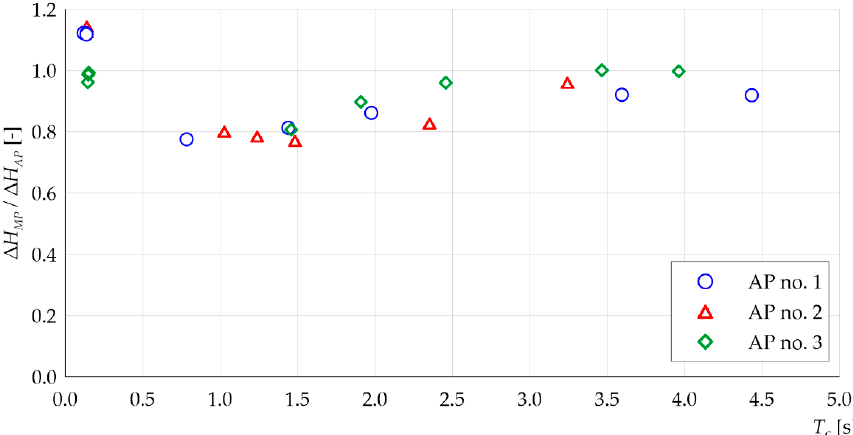
Figure 10. Values of Δ H MP / Δ H AP ratios as a function valve closing time (data obtained with sensors P M and P A